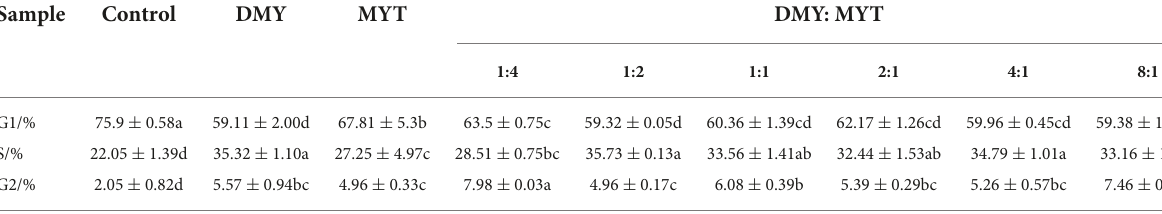
TABLE 4 Effects of the drugs on the cell cycle of B16F10 cells.